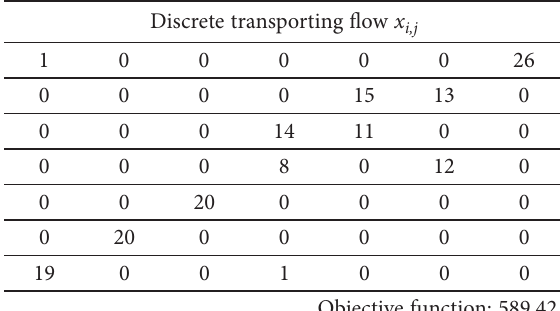
Table 12. Best obtained discrete solution for the 7×7 test problem with cost function E